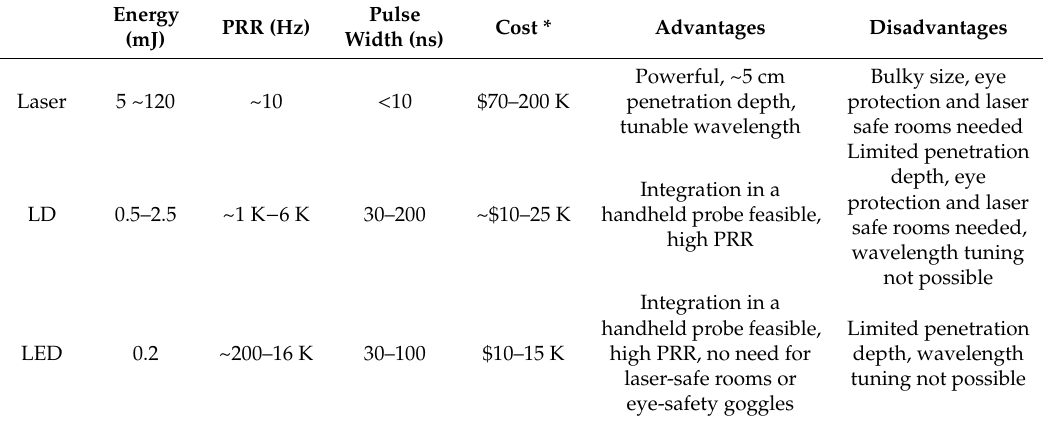
Table 1. Comparison of pulsed laser, laser diodes and LED